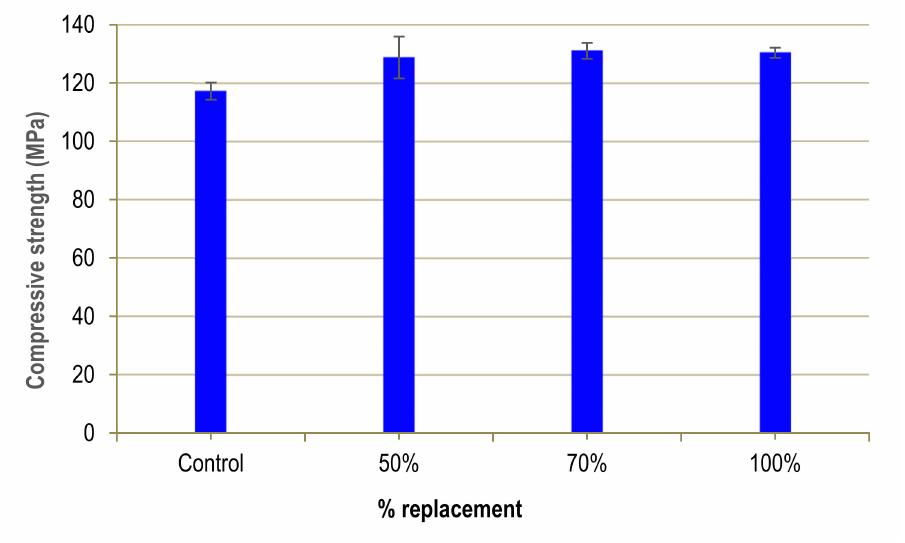
Figure 6. Compressive strength of